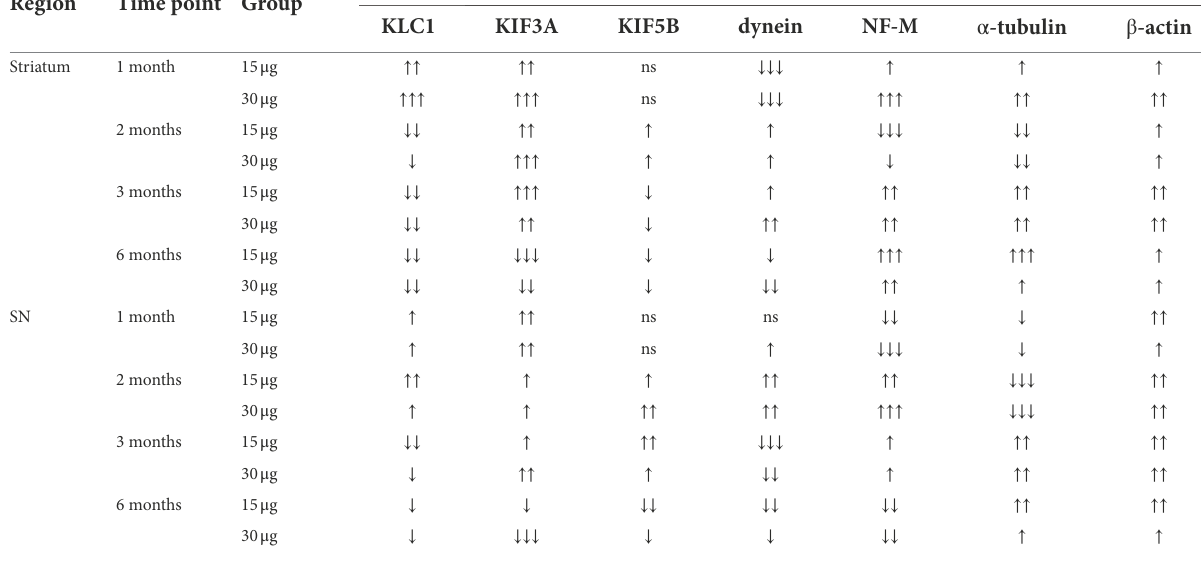
TABLE 1 Summary of the expression of axonal transport related proteins in the nigrostriatal system.